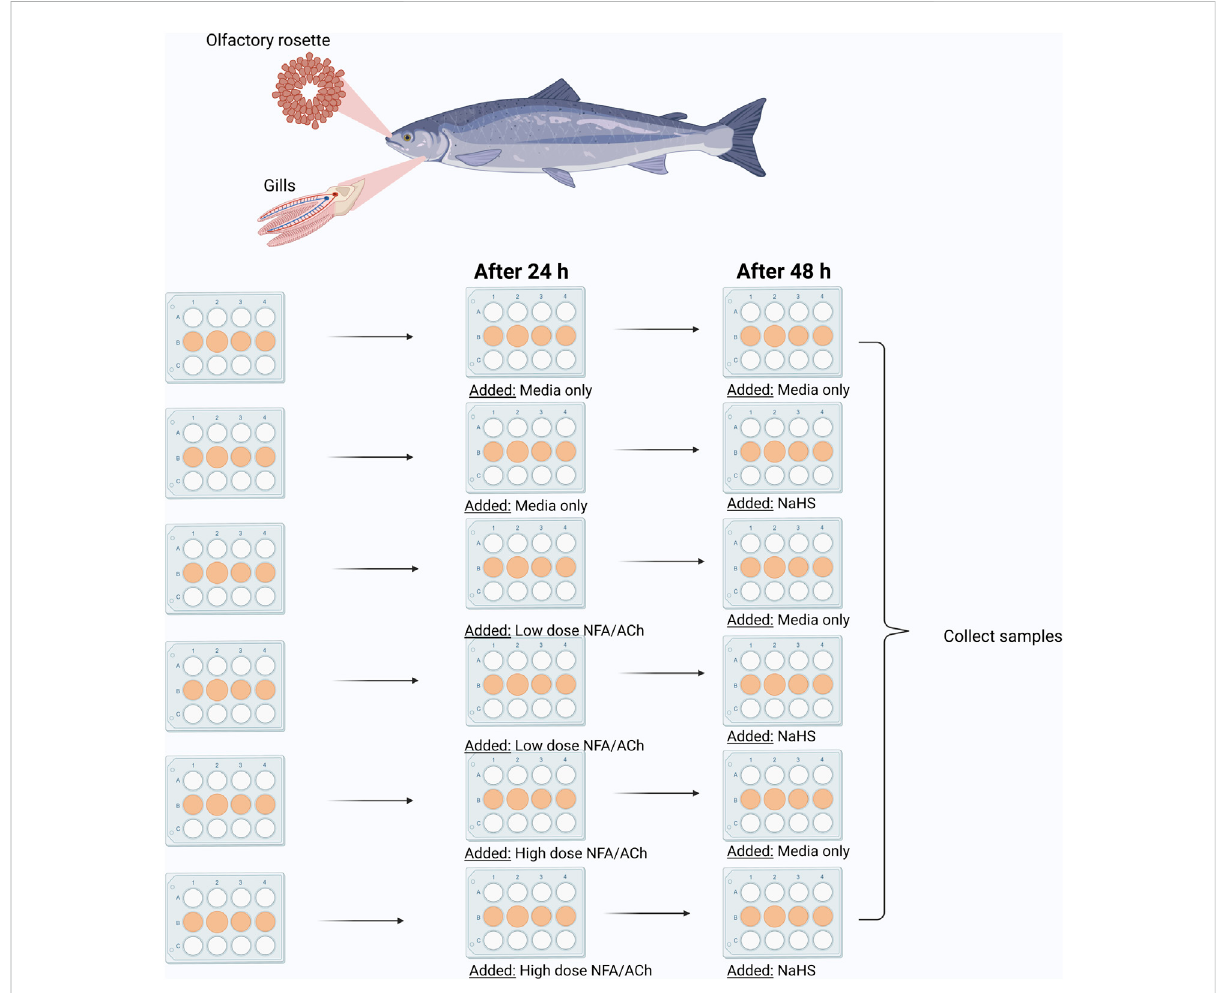
FIGURE 1 Graphic illustration of in vitro experimental set-up. Low NFA (50 μ M); High NFA (500 μ M); Low ACh (50 μ M); High Ach (500 μ M); NaHS (100 μ M). Created with BioRender.com (Agreement number